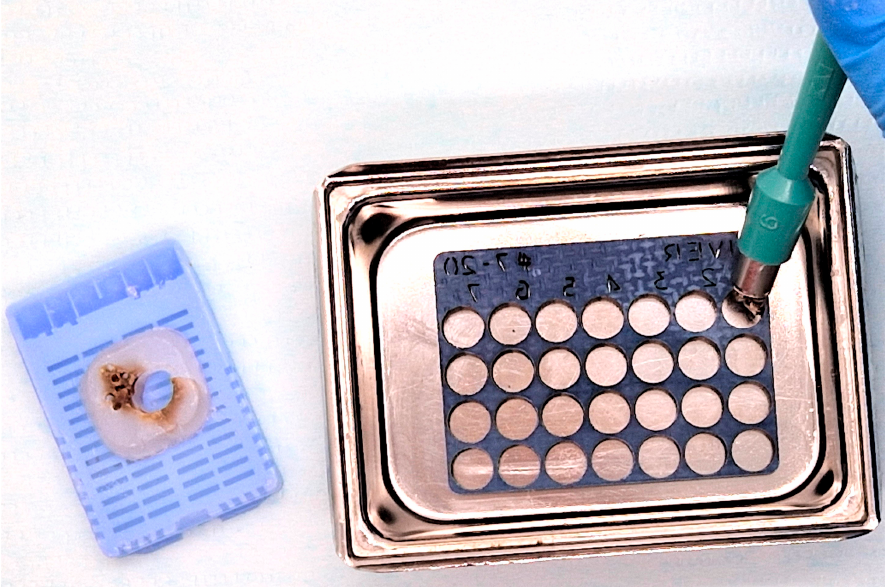
Figure 2. Liver tissue microarray—loading the support matrix with liver donor tissue. Tissue cores were extracted from the “donor” blocks with a 6 mm biopsy punch and arrayed in the TMA. Molten paraffin was poured slowly, avoiding the formation of air bubbles into the metal mold, and maintained on the hot plate of the embedding station for an additional 5 min. The mold was then cooled, and once the paraffin had solidified, the paraffin block